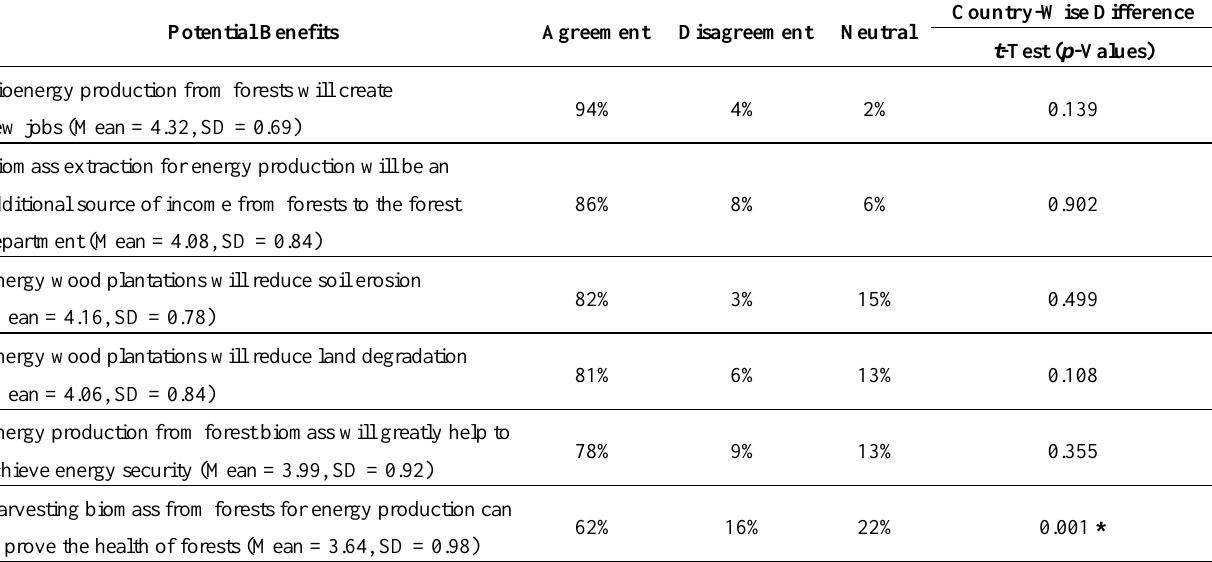
Table 1. State forestry professionals’ perceptions of the potential benefits of forest-based bioenergy projects in China and